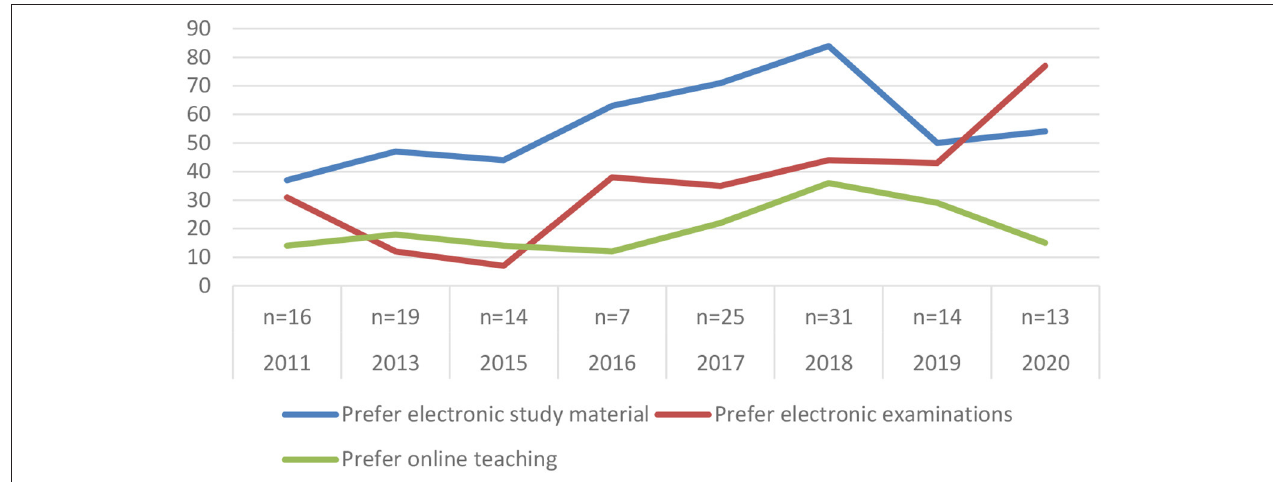
FIGURE 7 | Preference to online learning